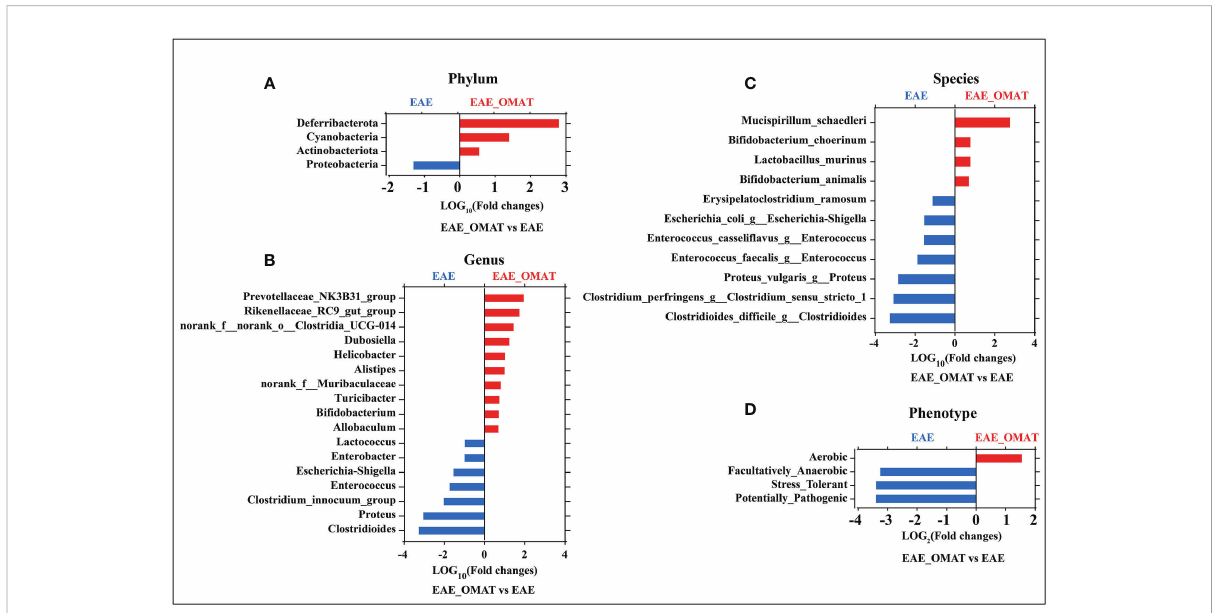
FIGURE 3 Effect of oxymatrine treatment on the gut microbial abundance and microbiome phenotypes in EAE mice. The fold-change (LOG 2 or LOG 10 ) of relative abundance at the level of phylum (A) , genus (B) , species and (C) , phenotype (D) between the EAE group and EAE_OMAT groups ( P < 0.05 ). The Z-score based on the abundance of each KEGG ortholog is depicted from lowest (blue) to highest (red) according to the scale shown at the top. The P value was determined based on the Wilcoxon rank-sum test with the Benjamini – Hochberg method for multiple group